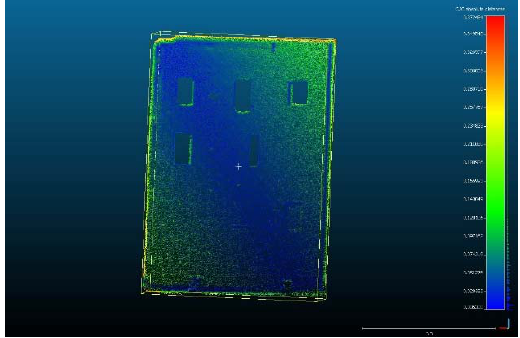
Figure 11: Discrepancy map between the TLS cloud and UAV VisualSfM processing.